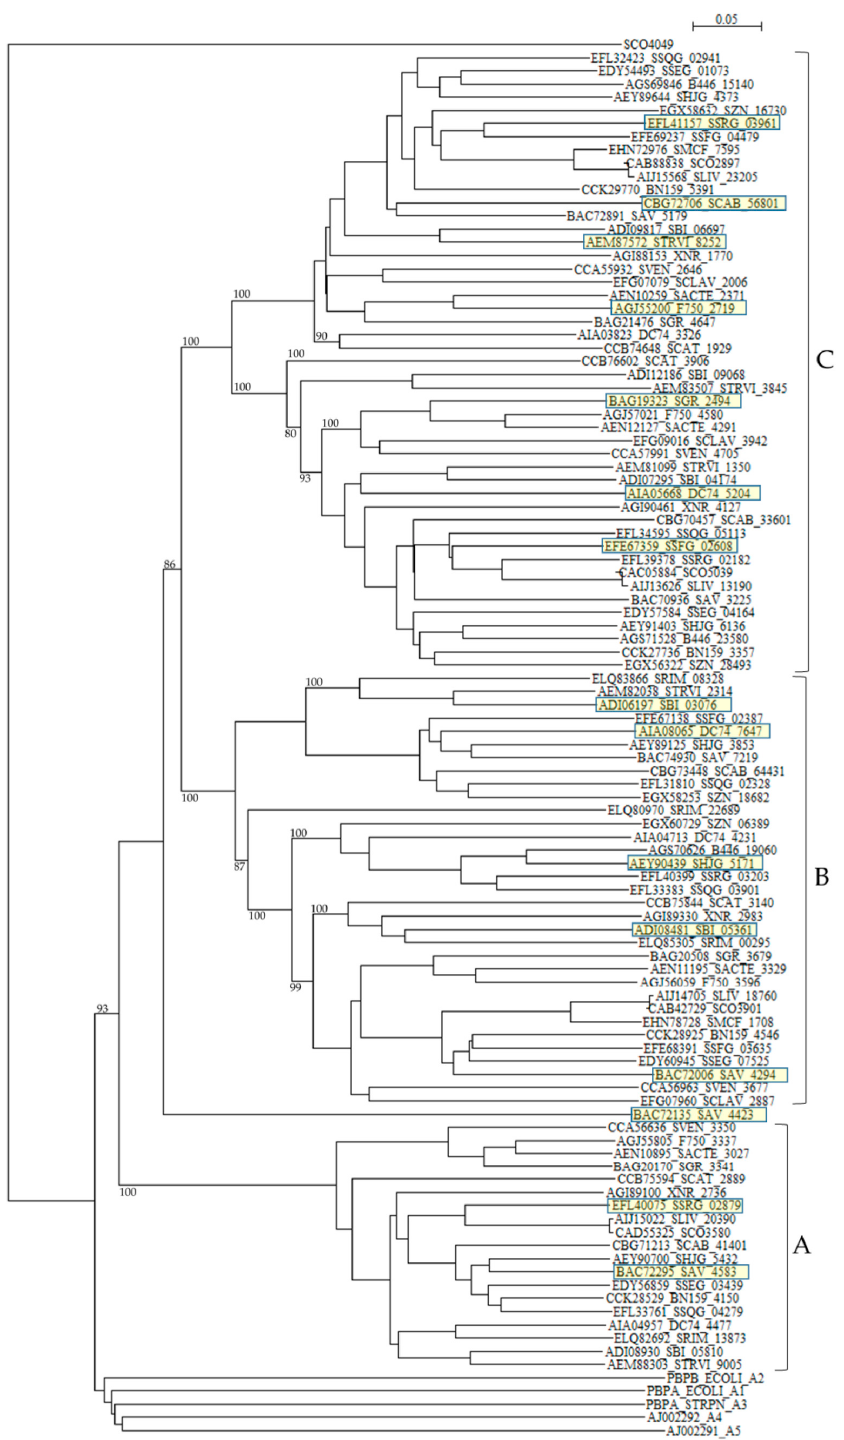
Figure 4. Phylogenetic tree of putative 100 class A PBPs on the basis of amino acid sequences. The tree was constructed by using ClustalX 2 [88] and S. coelicolor putative penicillin acylase (SCO4049, CAC32320) as outgroup. E. coli PBP1A (subclass A1, PBPA_ECOLI), E. coli PBP1B (subclass A2, PBPB_ECOLI), S. pneumoniae PBP1A (subclass A3, PBPA_STRPN), S. pneumoniae PBP2A (subclass A4, AJ002292), and S. pneumoniae PBP1B (subclass A5, AJ002291) were used as reference sequences. The sequences marked with yellow boxes were used for the calculation of molecular distances (Table S8). The PBPs in groups A, B, and C are corresponding to those in clusters A, B, and C in the amino acid alignment shown in Table S7. The bootstrap probabilities are shown at branching